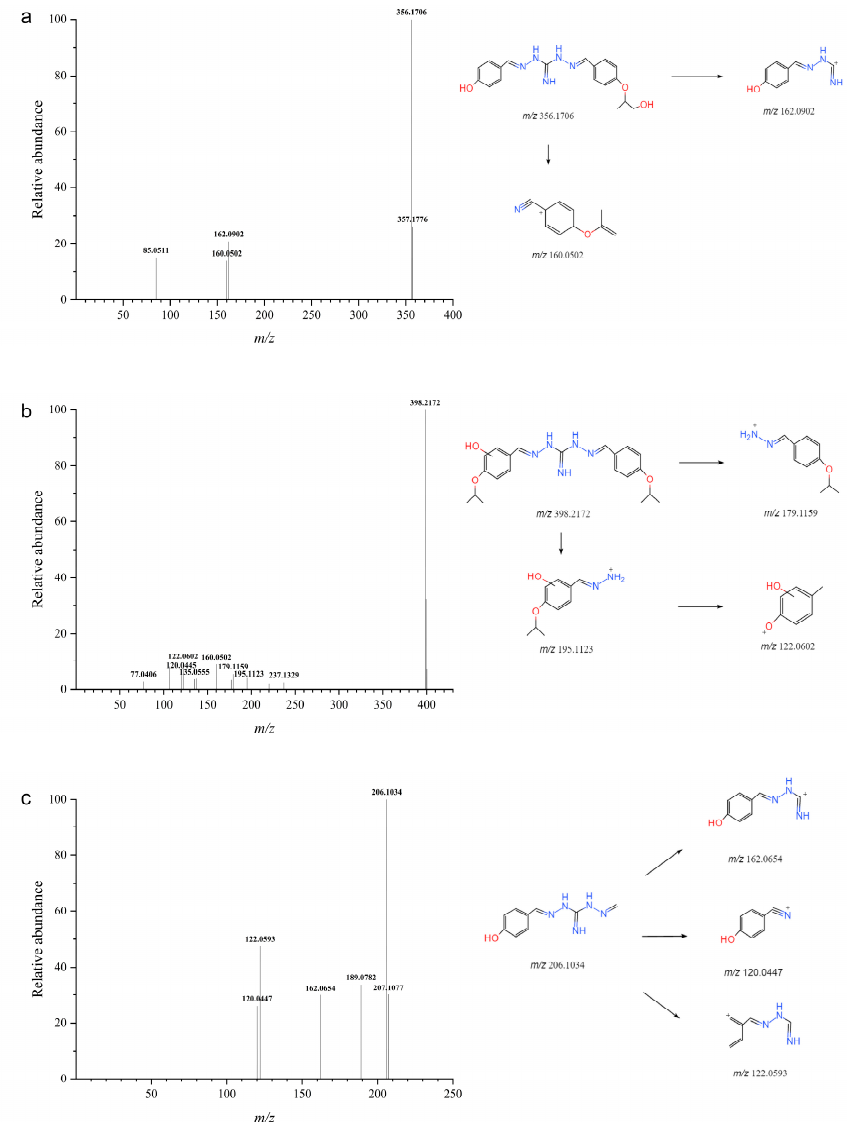
Figure 5. Collision-induced dissociation spectra of M5 ( a ), M6 ( b ), and M7 ( c ), along with their proposed fragmentations.